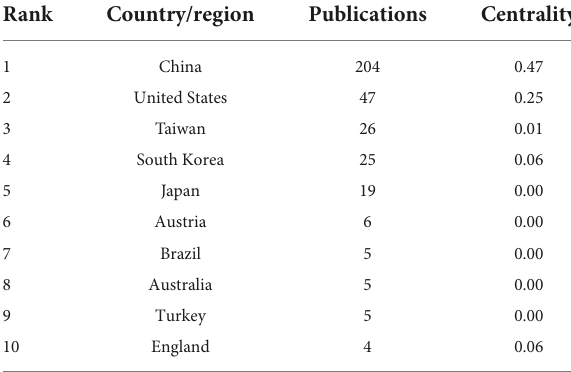
TABLE 2 The top 10 active countries/regions.